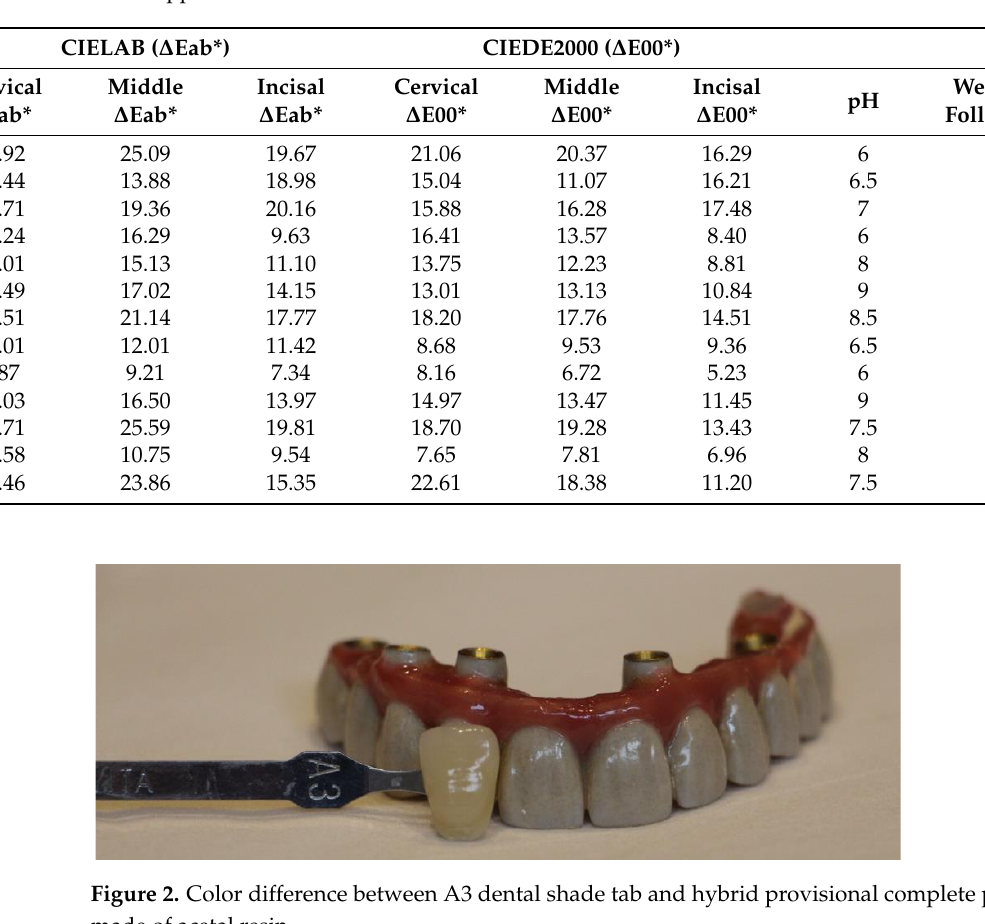
Figure 3. Colour differences (∆Eab* and ΔE00*) exceeded the threshold of clinical acceptability. With both formulas, the ANOVA with one factor of variation (thirds of the tooth) in a randomised block design (subjects) revealed that the chromatic changes in the three areas differed significantly ( p = 0.002). Subsequently, Duncan ’ s test showed that